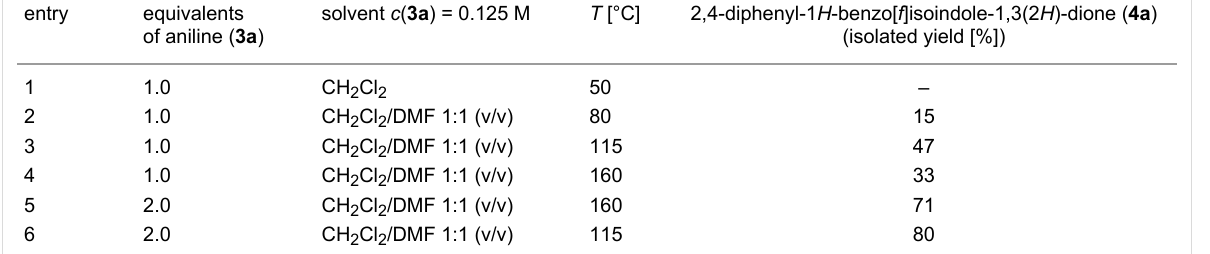
Table 3: Optimization of the reaction conditions for the synthesis of 2,4-diphenyl-1 H -benzo[ f ]isoindole-1,3(2 H )-dione ( 4a ).